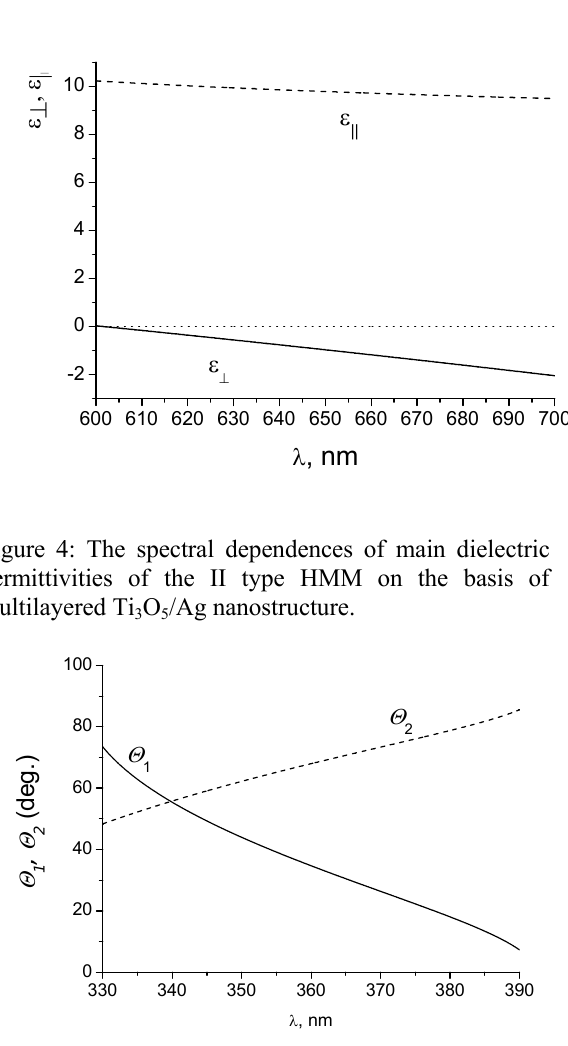
Figure 5: The spectral dependences of the angles =arcsin (Y ) 1/2 for the I type HMM on the basis of Θ 1,2 1,2 multilayered Ti O /Ag nanostructure. 3 5